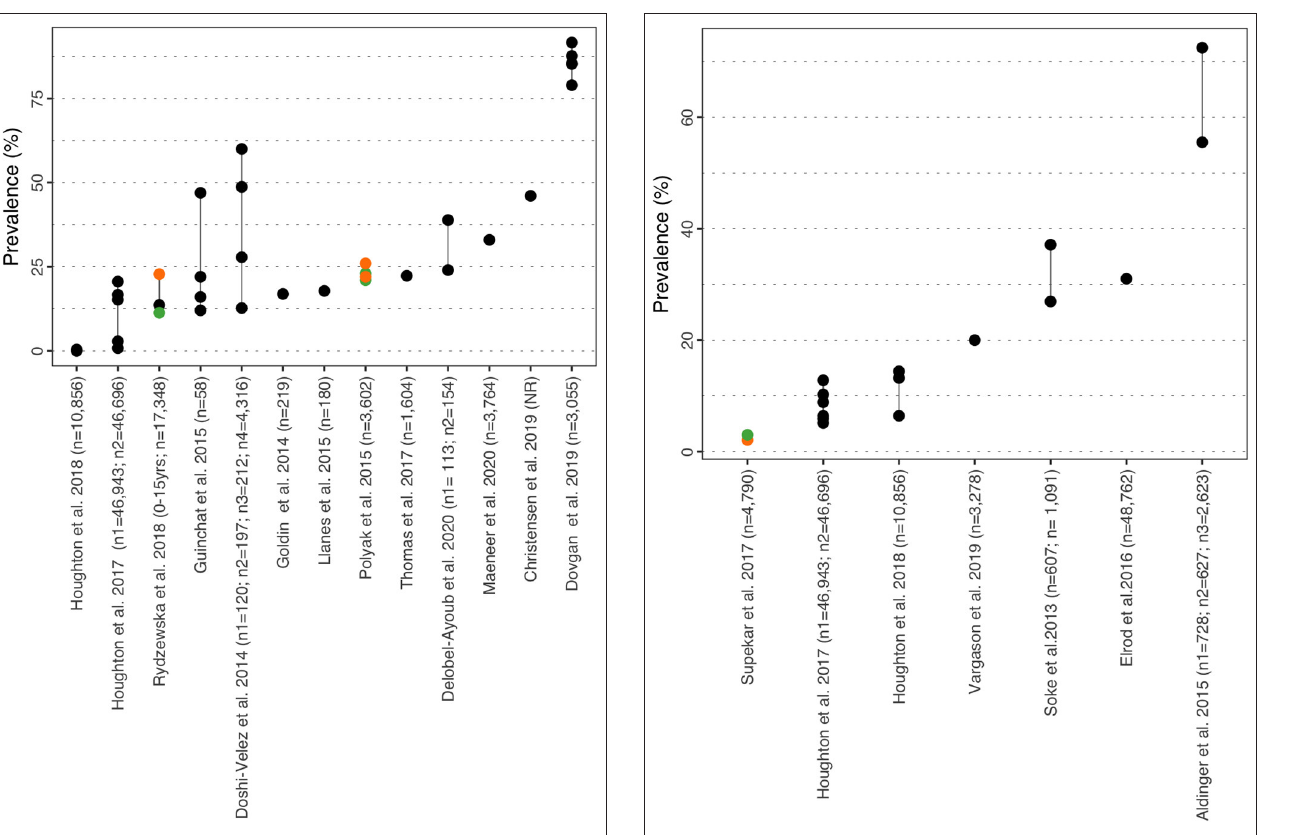
FIGURE 10 | Sleep disorder prevalence estimate. Each point reports a prevalence estimate for the related comorbidity. Studies with more than one data point indicate the estimate of the prevalence among different subgroup of the population. See Supplementary Table 4 for the description of the population used in each study. Sample sizes are shown in brackets above each study label. Orange mark: Female population only; Green mark: Male population only; Black mark: No sex